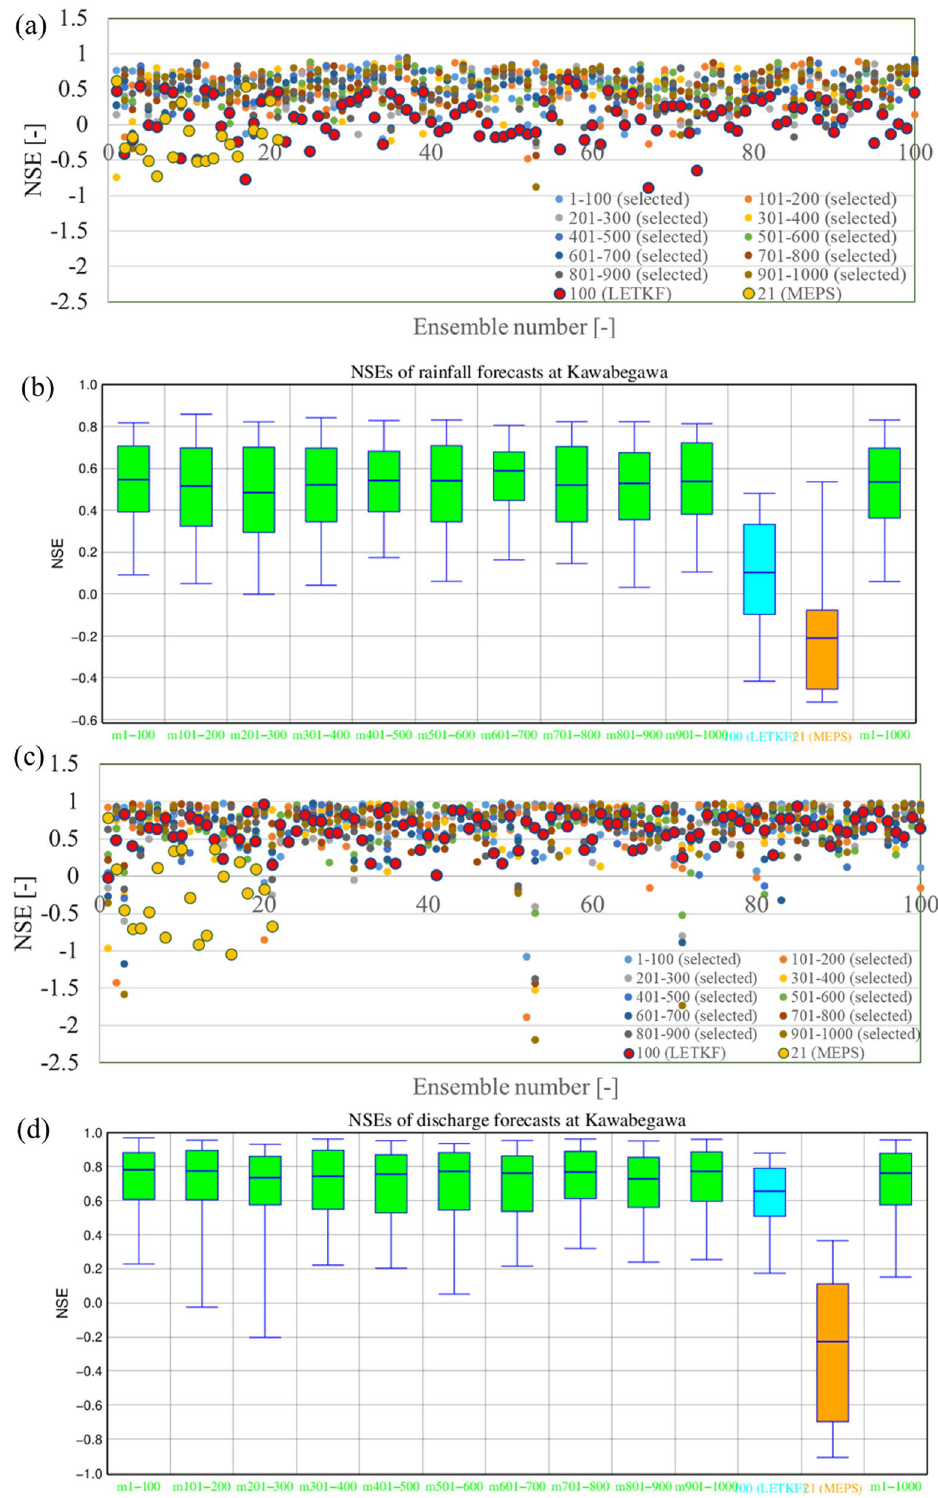
Fig. 15 a NSEs of rainfall, b NSE box plots of rainfall, c NSEs of discharge and d NSE box plots of discharge for Ichifusa